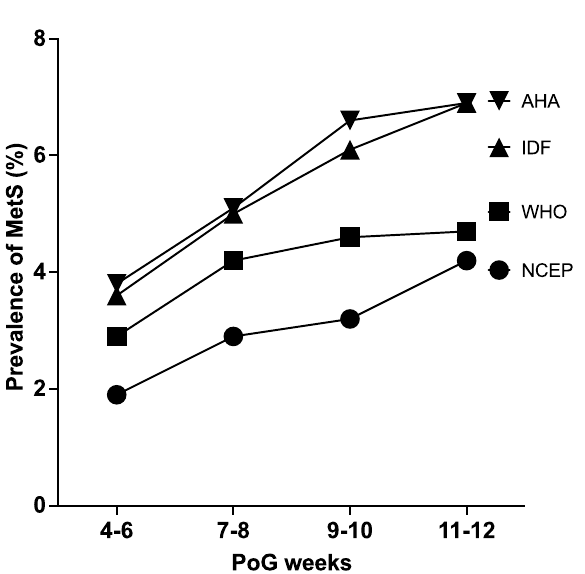
Figure 2. Prevalence of metabolic syndrome by each definition within categories of the period of gestation (POG) ( AHA/NHLBI American Heart Association/National Heart, Lung and Blood Institute, IDF